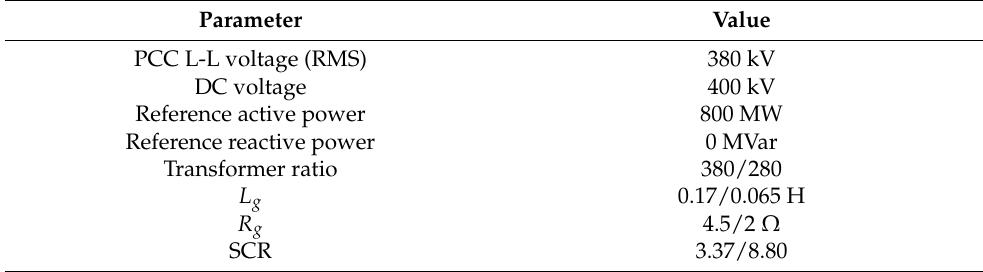
Figure 5. Bode plot of Eigenvalues of the return ratio matrix: ( a ) Eigenvalue λ 1 ; ( b ) Eigenvalue λ 2 . Table 1. System